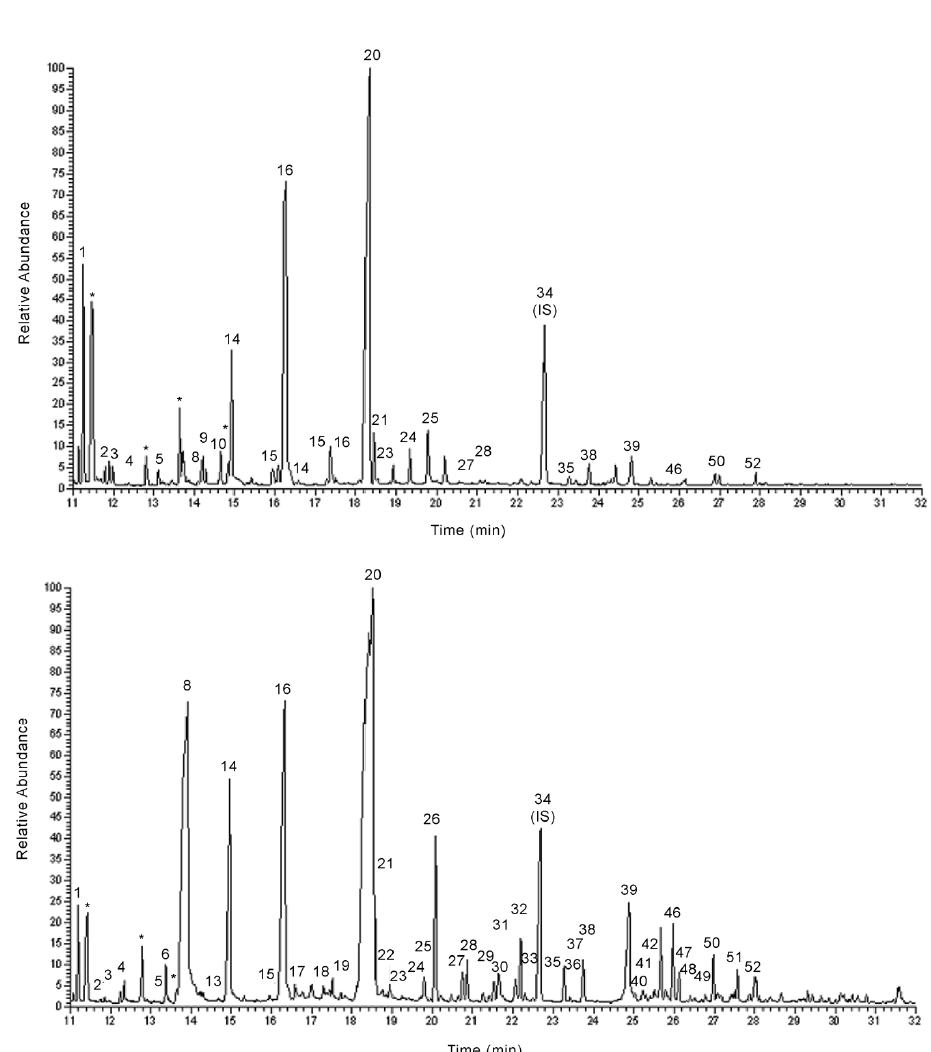
Fig. 3. GC-MS total ion chromatogram of organic extracts as BSTFA derivatives for particle-phase products from the photooxidation of MBO in the absence (top) and presence (bottom) of acidic sulfate aerosol.